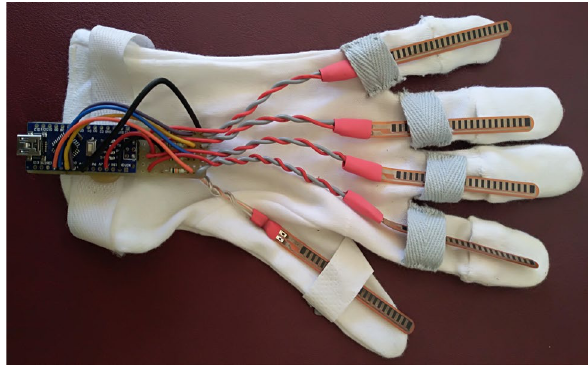
Figure 2. First prototype of the cyberglove used in Silico.